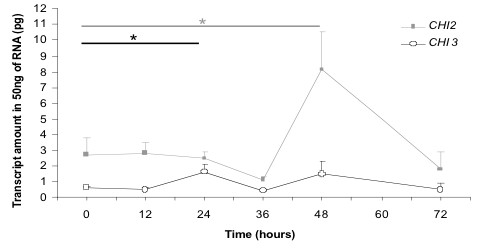
Significant changes of temporal expression of CHI2 and CHI3 mRNAs. The transcript abundance changes during 72 hours of growth in chitinless, liquid PG-1 medium. The significant differences in temporal expression indicate functional constraint and are in accordance with the plurifunctionality of GH18 family members, respectively. Error bars (only the positive error bar is shown) represent the standard errors of the mean obtained from three independent time-course experiments. The asterisk designates significance at p < 0.05.